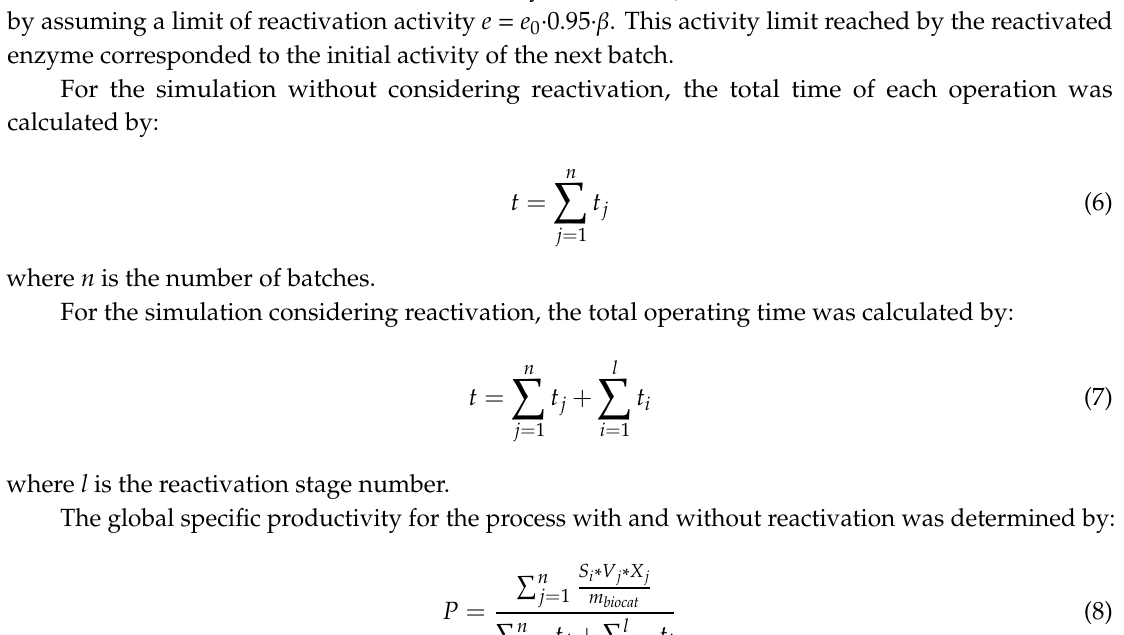
Figure 2B. Processes 2020 , 8 , x FOR PEER REVIEW